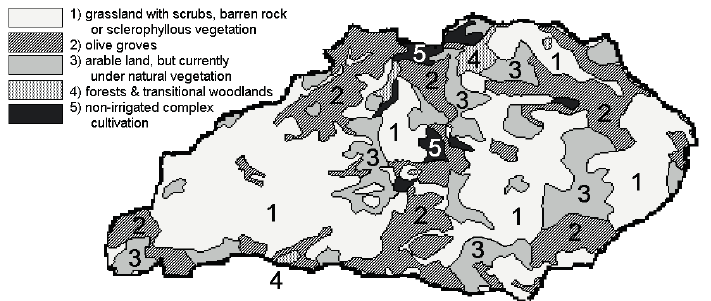
Fig. 2 Simplified land forms map of Wadi Natuf (modified after LRC